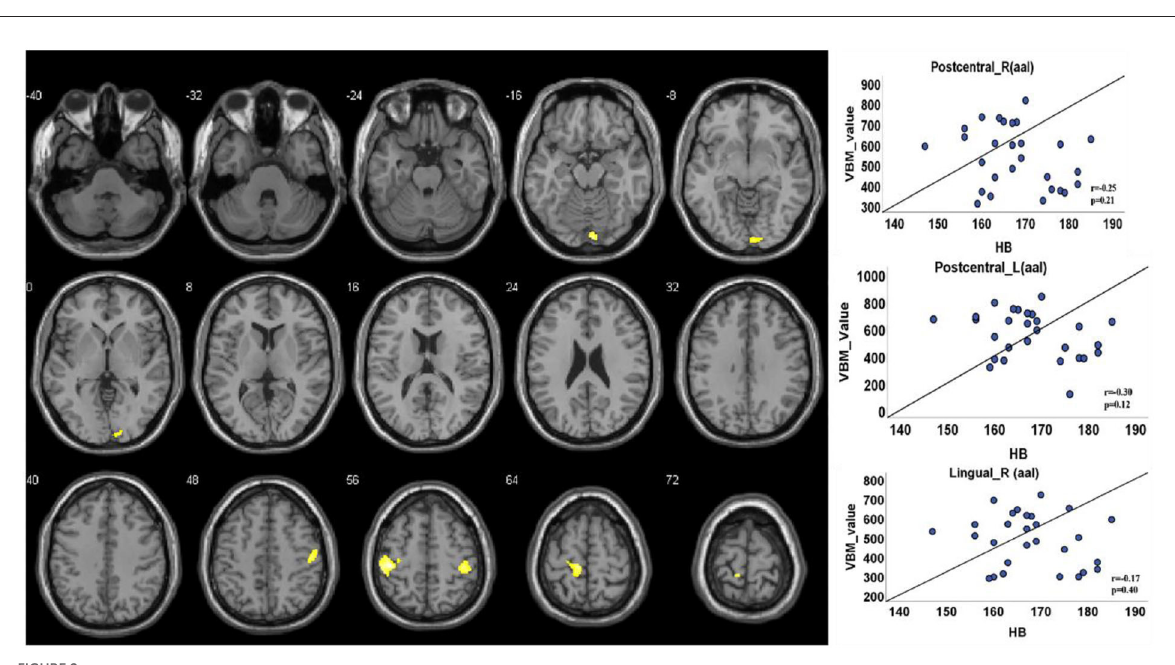
FIGURE2 Gray matter structure cluster area differs from HA to CG and uncorrelates with Hb. The volume is significantly higher with the people of HA than CG. The color yellow represents the brain regions that positively activate gray matter. Correlations with Hb: Right lingual ( r = 0.17, p = 0.40); right postcentral ( r = 0.25, p = 0.21); left postcentral ( r = 0.30, p =